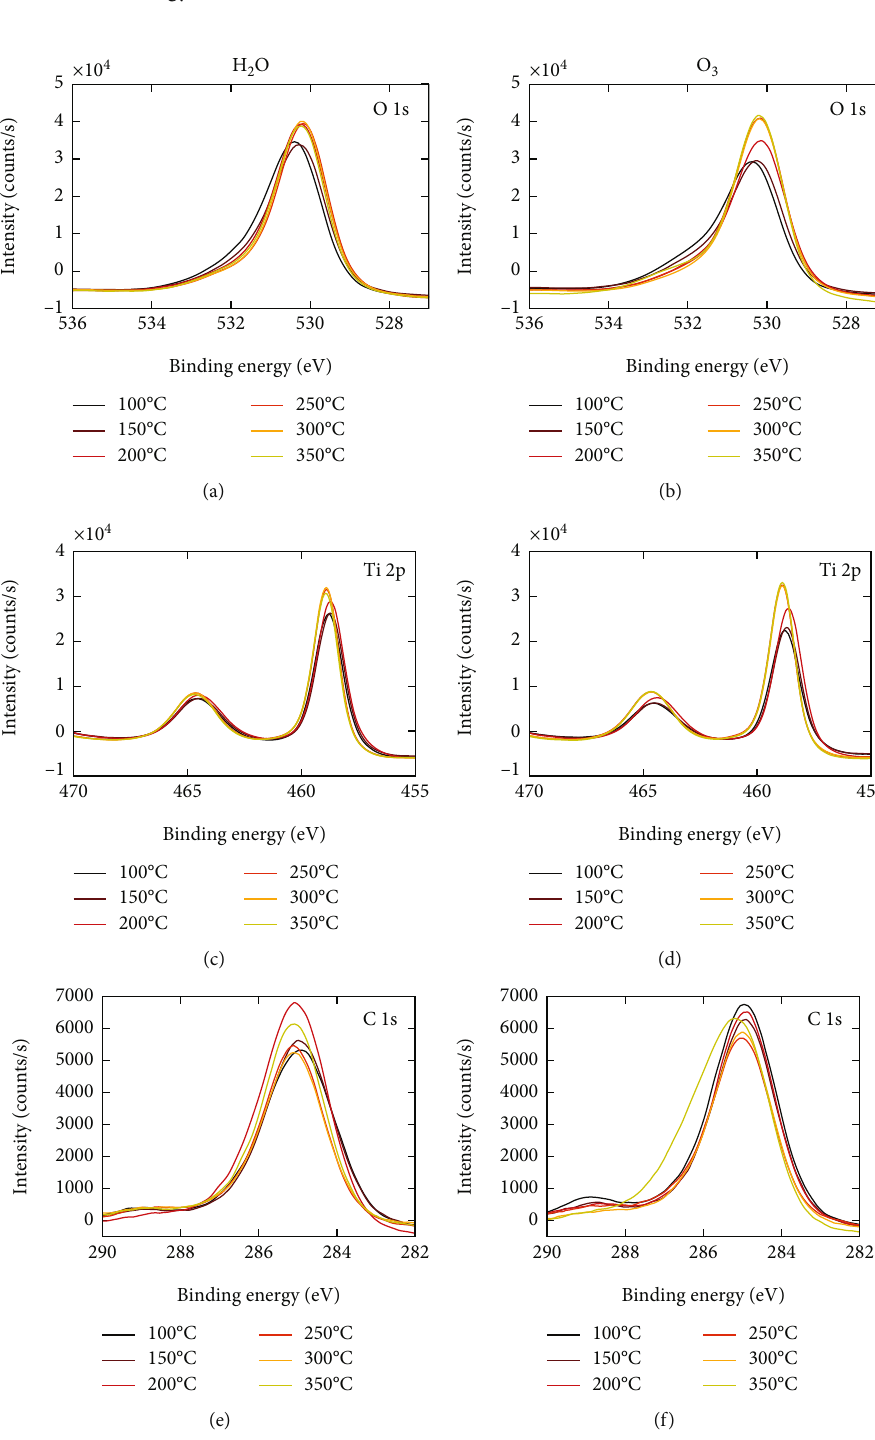
samples with (a, c, e) H 2